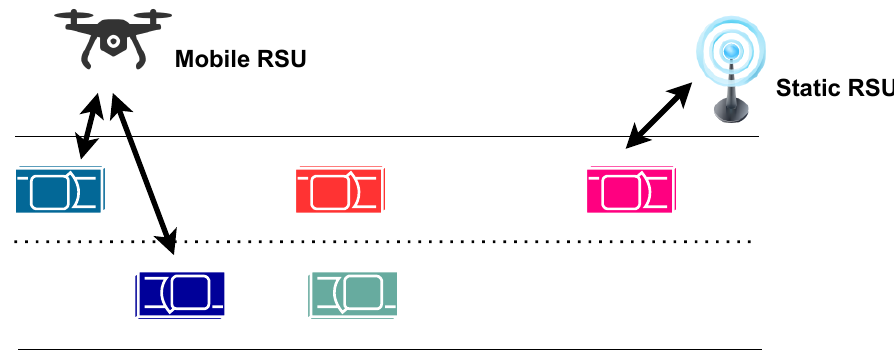
Figure 5. UAV as